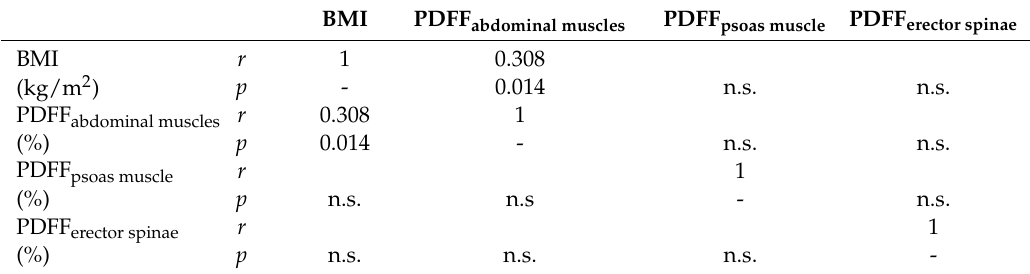
Table 7. Partial correlations for women with age as a control variable.